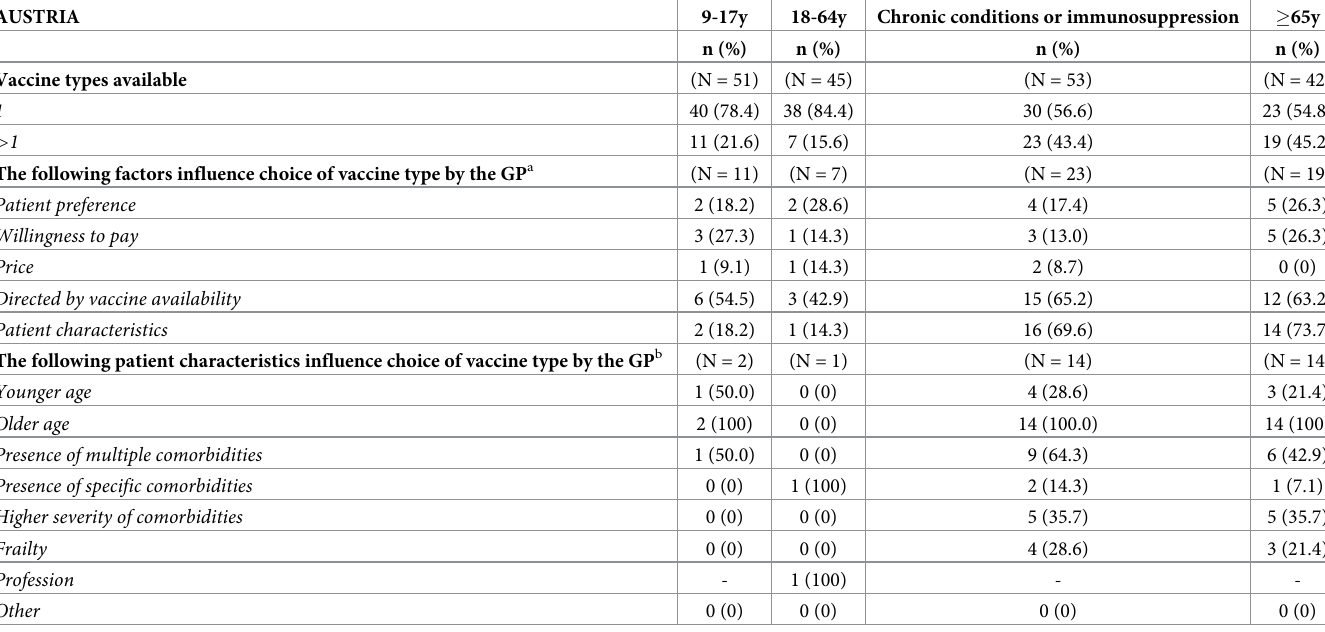
Table 4. Vaccine type availability and factors that influence choice of vaccine type by the GP in 2019/2020, by risk group, Austria.